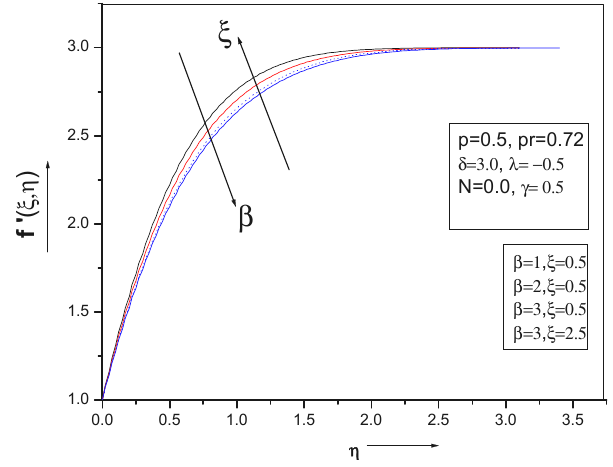
Figure 2. Effect of the body force magnetic parameter on velocity profile.